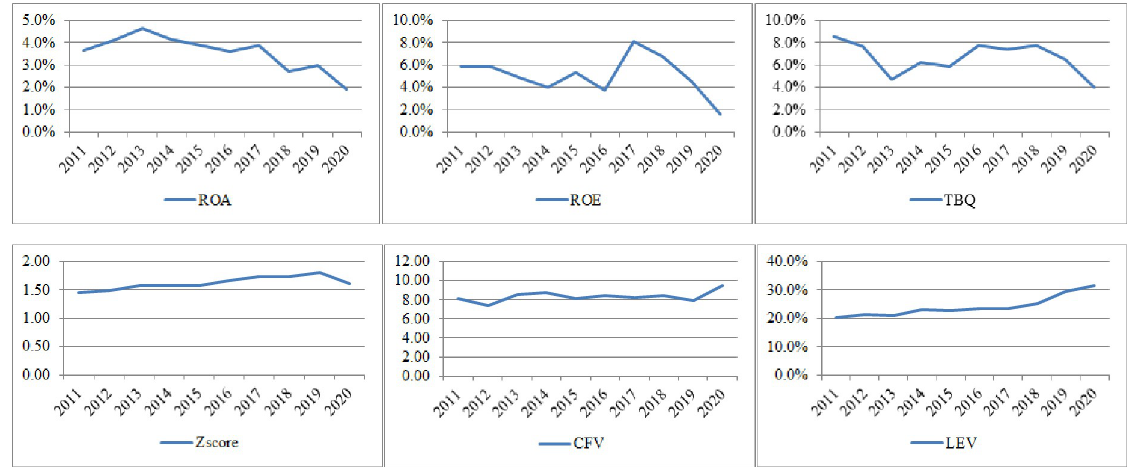
Fig 2. Firm risk and performance in MENA countries (average value). Source : Authors’ calculation .